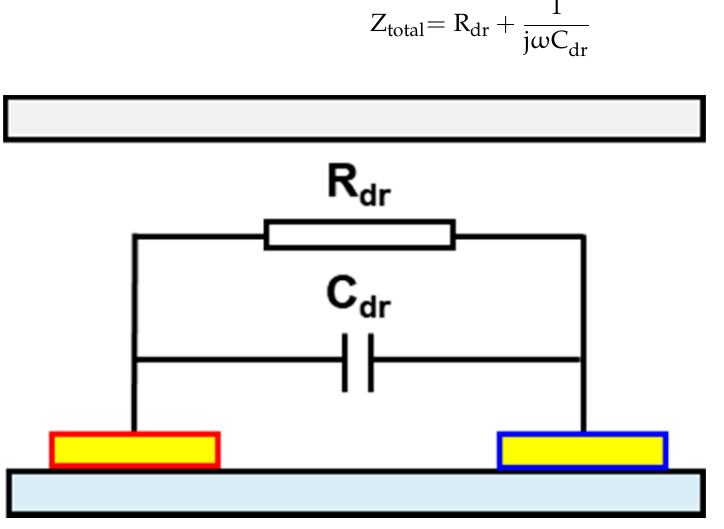
Figure 2. Equivalent electrical circuit of the detection region.